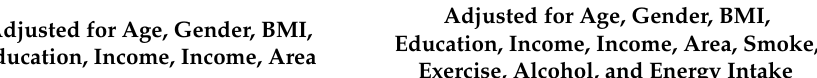
Table 4. Generalized multifactor dimensionality reduction (GMDR) results from multi-locus inter- action with genes related to β -cell function for type 2 diabetes risk.